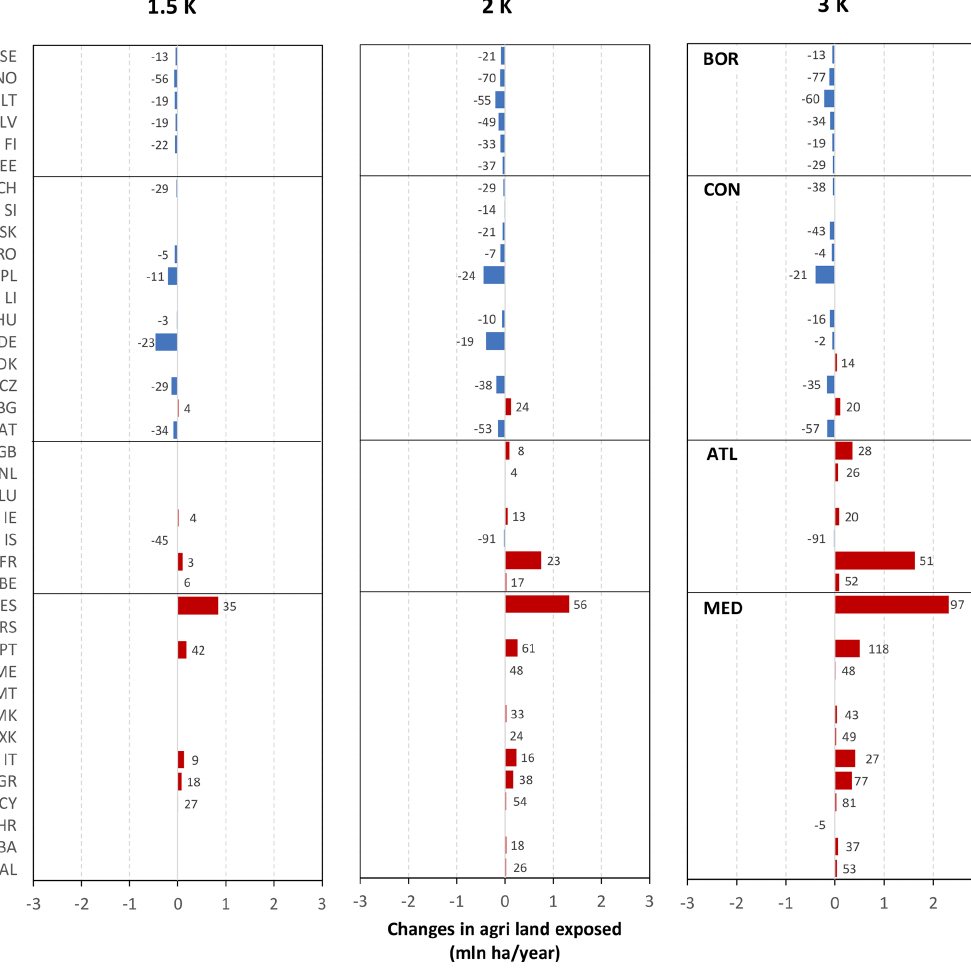
Figure 6. Changes in agricultural land exposed per country ( × 10 6 ha per year). Positive values indicate an increase in the area exposed. The numbers near the bars represent the percentage changes relative to the baseline (only if greater than